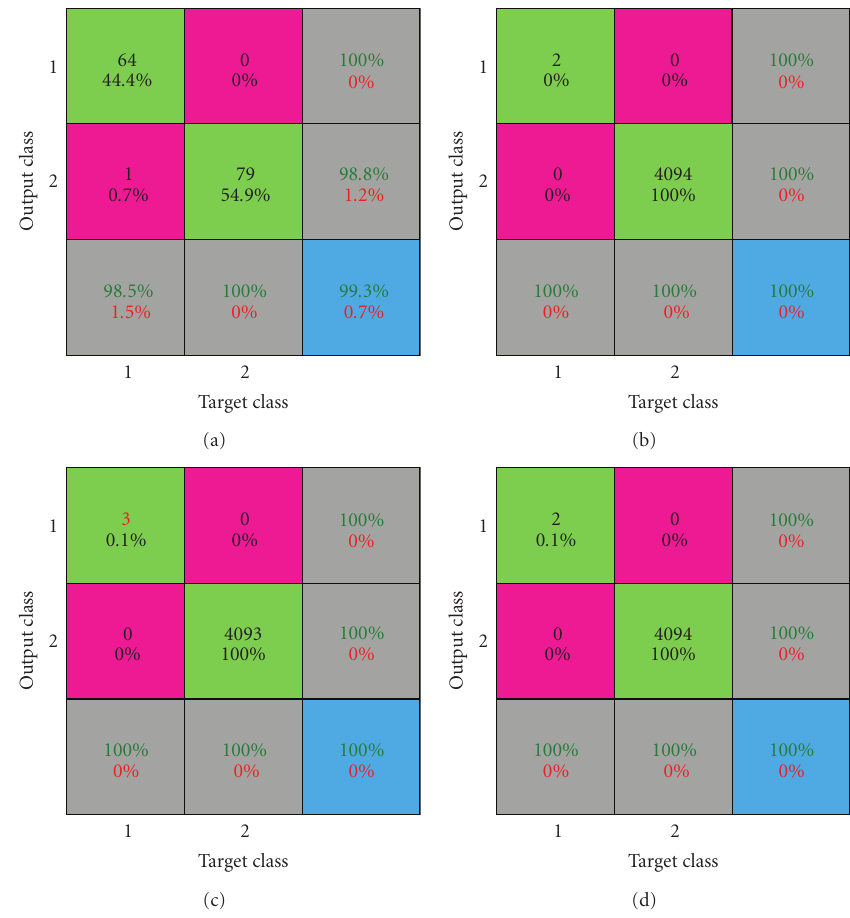
Figure 8: Confusion matrix: (a) for phantom data set 1, sphere 1, (b) phantom data set 2, tumour 1, (c) phantom data set 2, tumour 2, and (d) for phantom data set 2, tumour